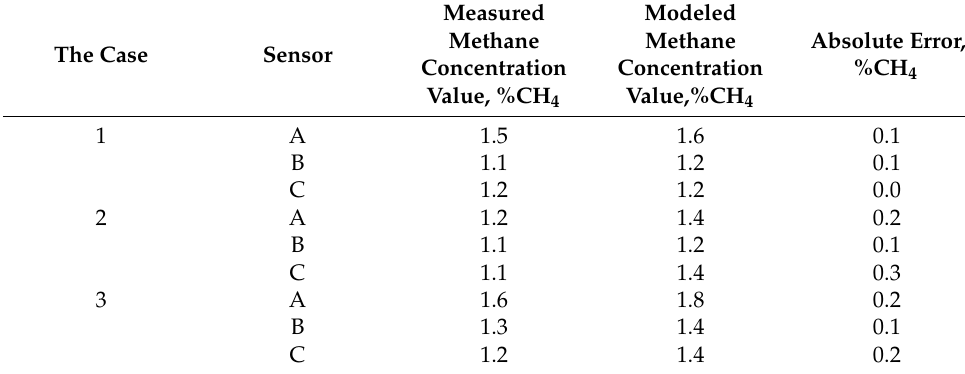
Table 3. Values of errors in the simulation of methane concentrations.